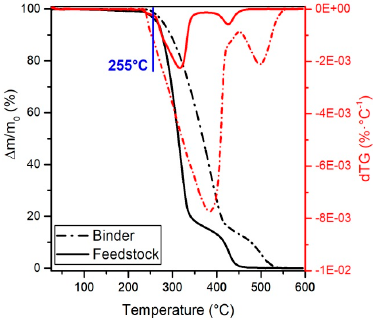
Figure 5. Representative curves of the amount of binder left in samples as temperature increases, and of the derivative of the binder left in the samples at different temperatures for the binder and feedstock. The nozzle temperature (255 °C) used in the FFF shaping is indicated in blue.